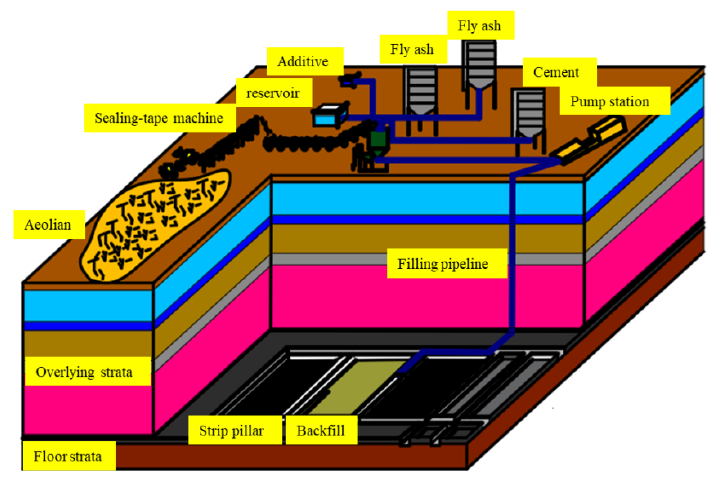
Figure 1. Strip filling diagram.